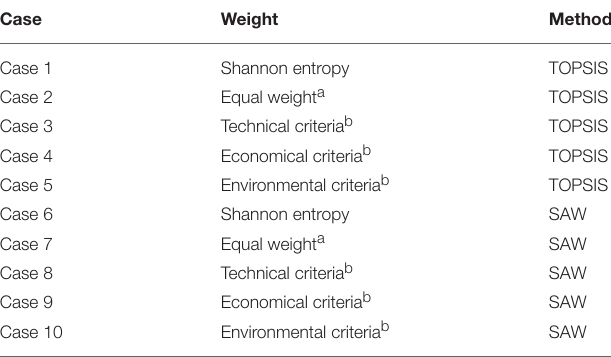
TABLE 1 | Different case studies involved in the sensitivity